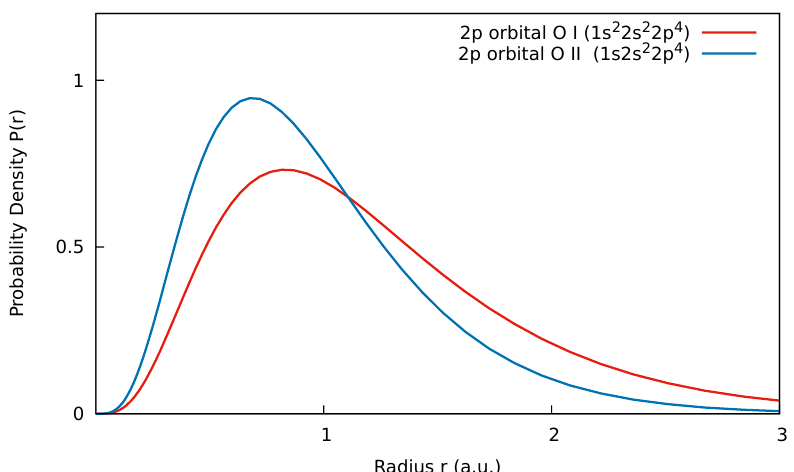
Figure 7. Probability density of the Hartree–Fock 2p orbital in the initial O I 1s 2 2s 2 2p 4 ground state compared to the 2p orbital in the final O II 1s2s 2 2p 4 K-vacancy state. The 2p electrons of the latter are screened from the nucleus by one fewer inner-shell 1s electron and are therefore “relaxed” to more tightly bound